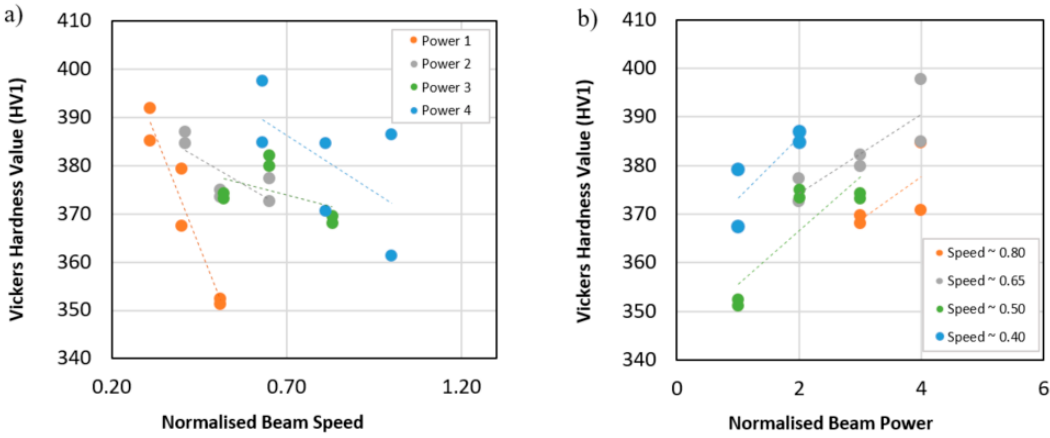
Figure 15. Influence of ( a ) normalised beam speed and ( b ) normalised beam power on average hardness values.